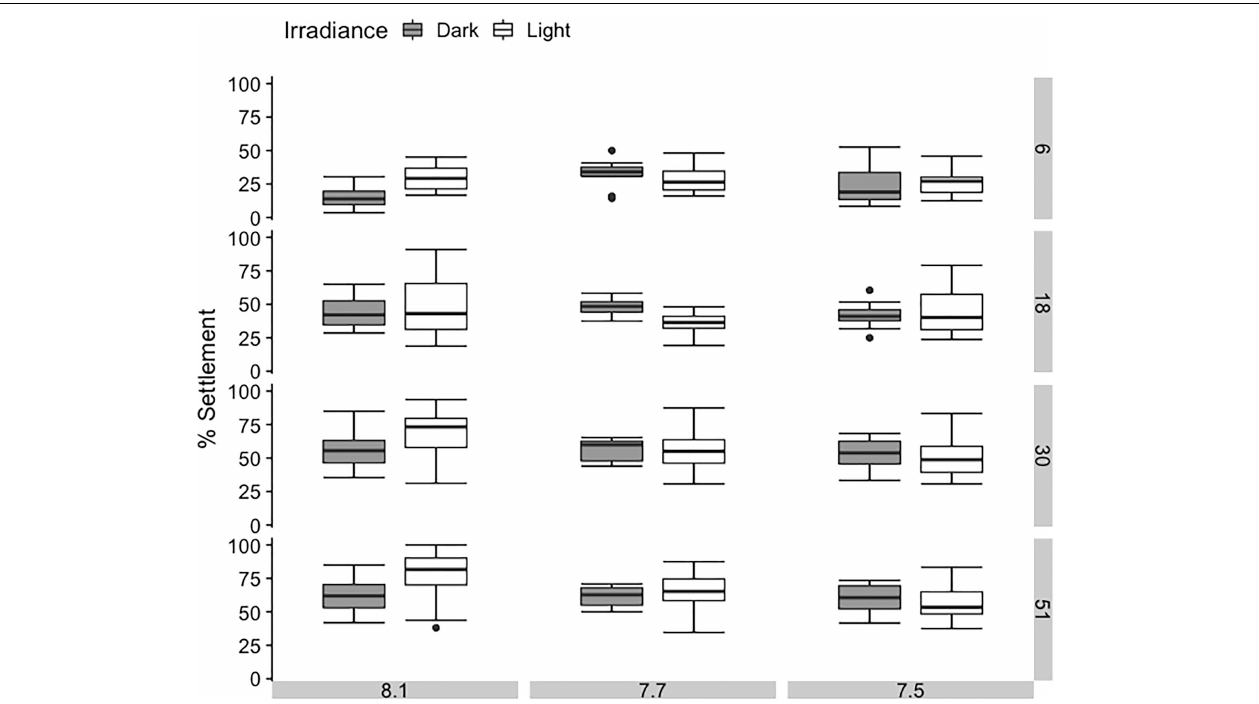
FIGURE 3 | Average percentage settlement of sea urchins Pseudechinus huttoni during a 51-h period under three bulk seawater pH and two irradiance treatments. Each treatment (3 L aquaria) contained four inverted chambers and was replicated three times. Error bars are ± 1 SE of the mean.